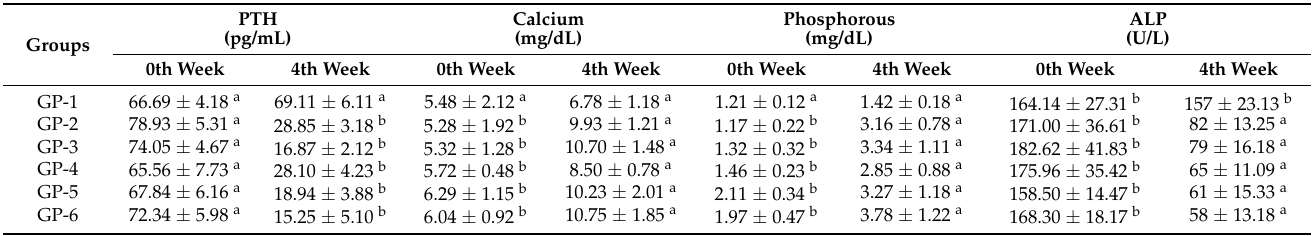
Table 4. Changes in the biochemical parameters before and after 4 weeks of feeding